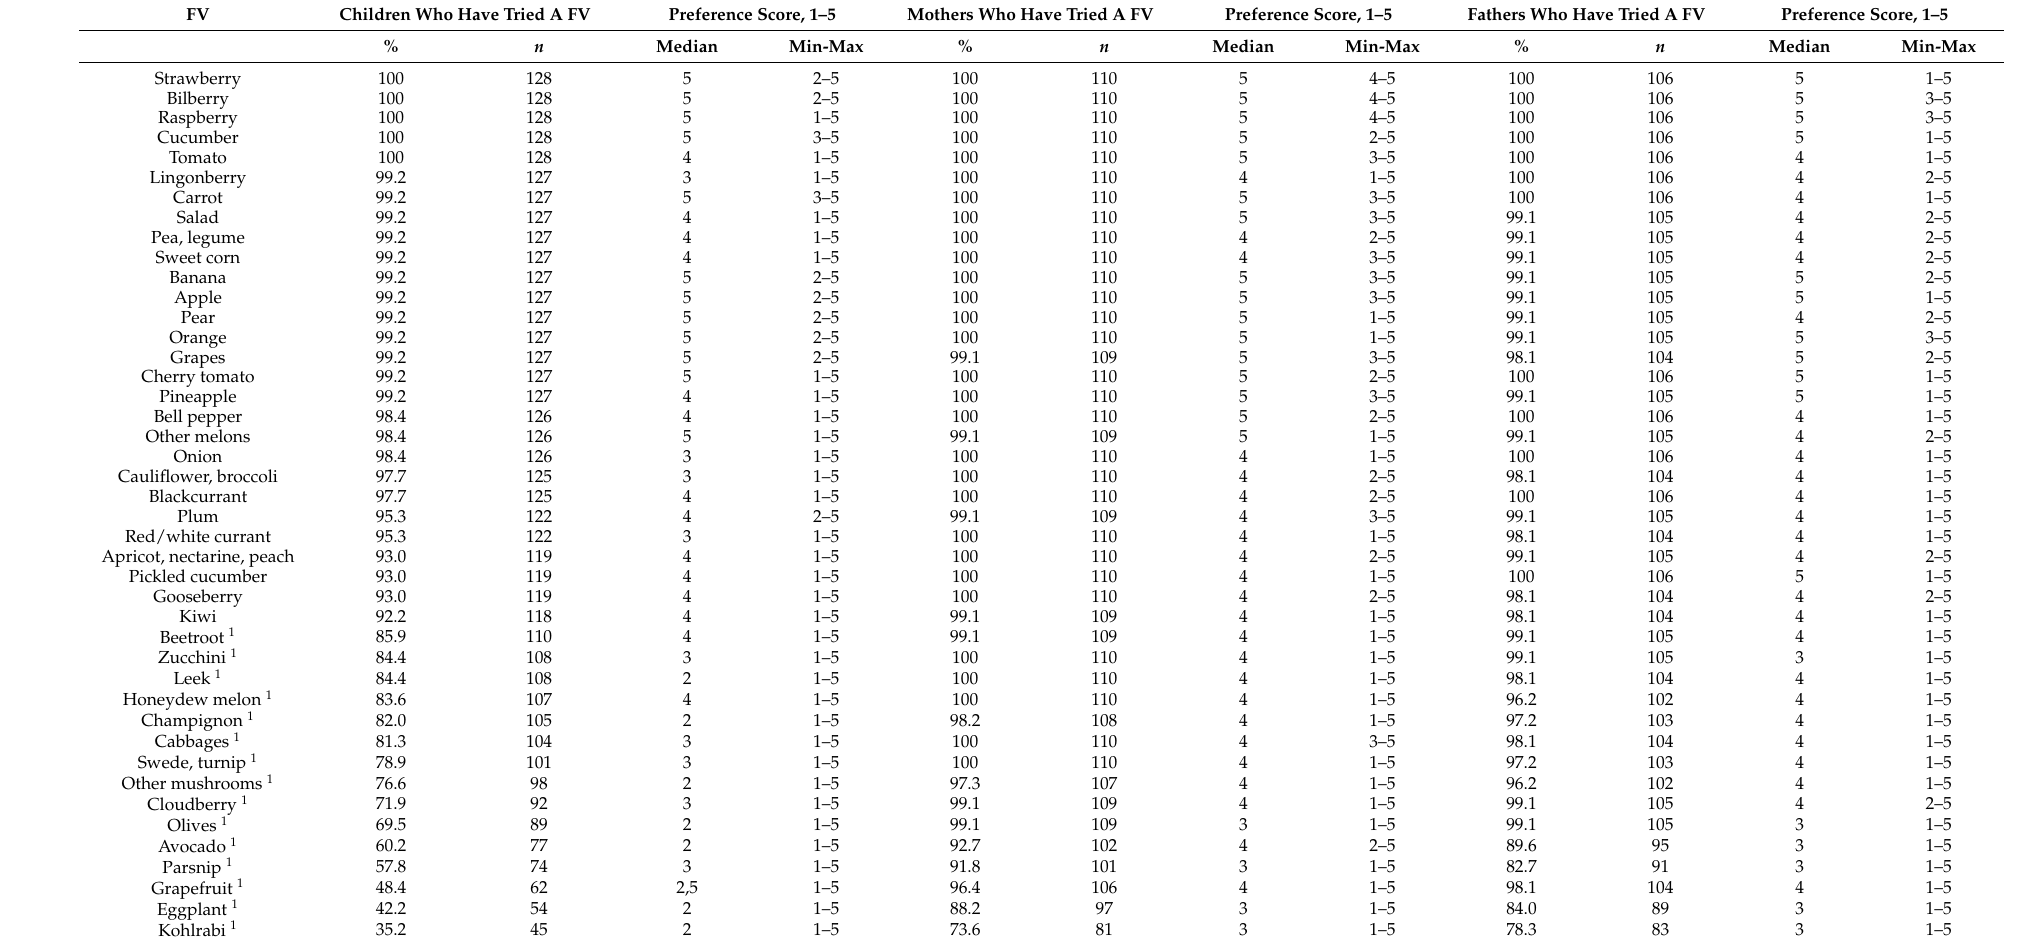
Table 2. Fruit and vegetable (FV) preferences (scale 1–5, 1 = I do/my child does not like this at all, 5 = I like/My child likes this a lot) of the 3–5-year-old children and their mothers and